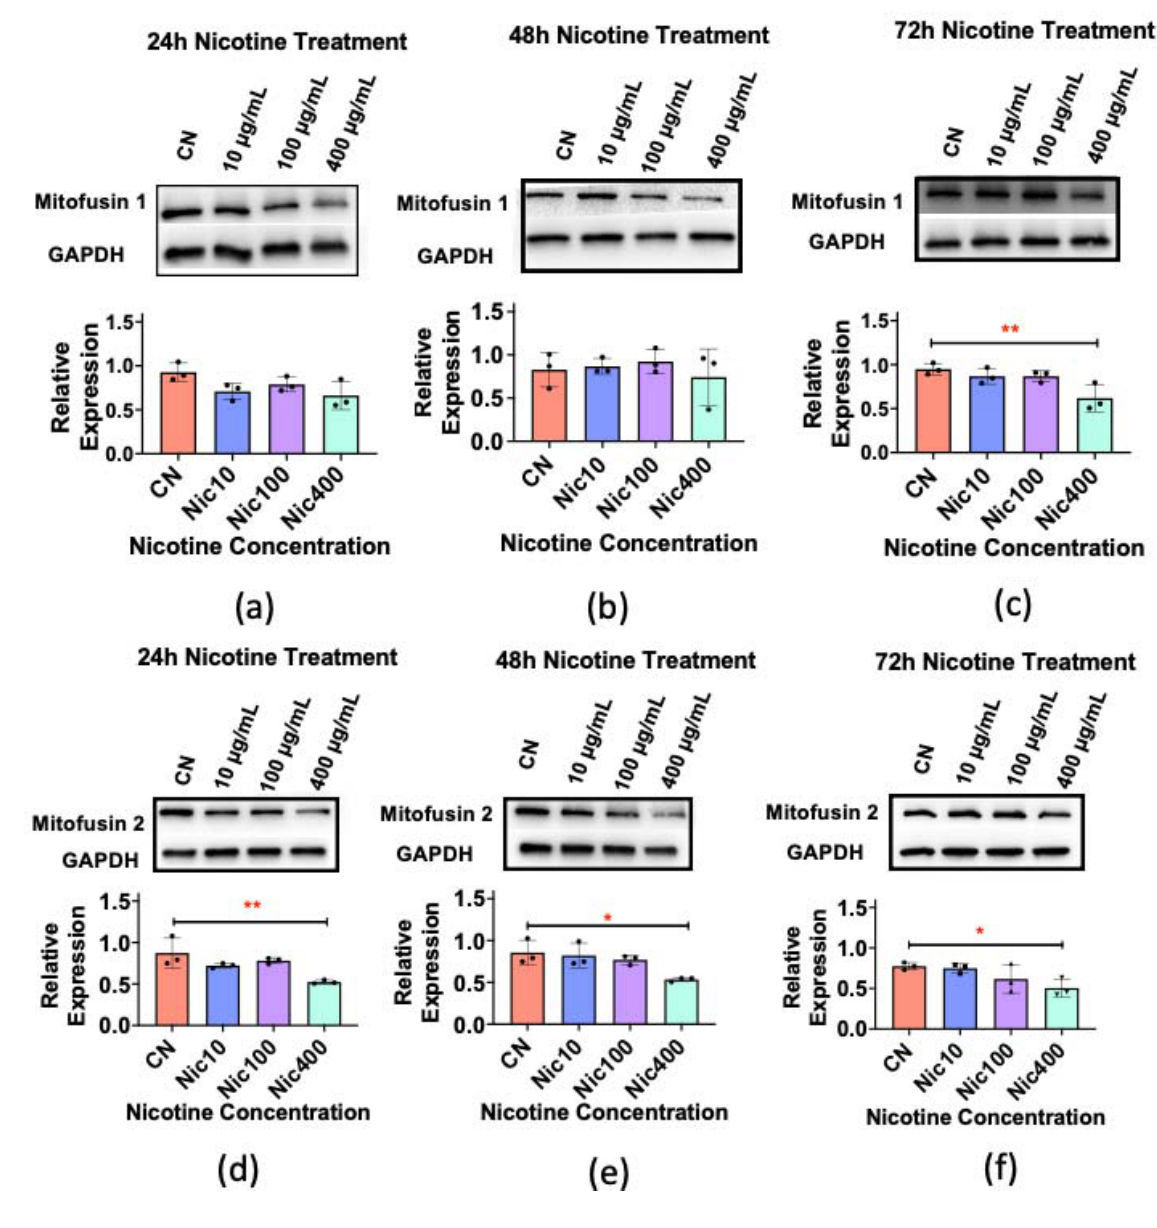
Figure 3. Mitofusin 1/2 protein in keratinocytes after nicotine treatment. Mitofusin 1 in Western blots after 24 h ( a ); 48 h ( b ); and 72 h ( c ) of nicotine treatment. Mitofusin 2 in Western blots after 24 h ( d ); 48 h ( e ); and 72 h ( f ) of nicotine treatment. CN = control medium. All data are means ± the standard error of the mean for three independent experiments represented by black dots. * = p < 0.05, ** = p < 0.01.